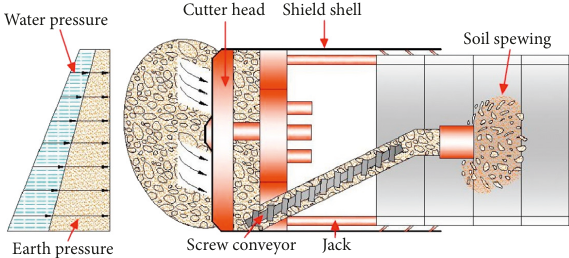
Figure 1: Schematic diagram of EPBS slag